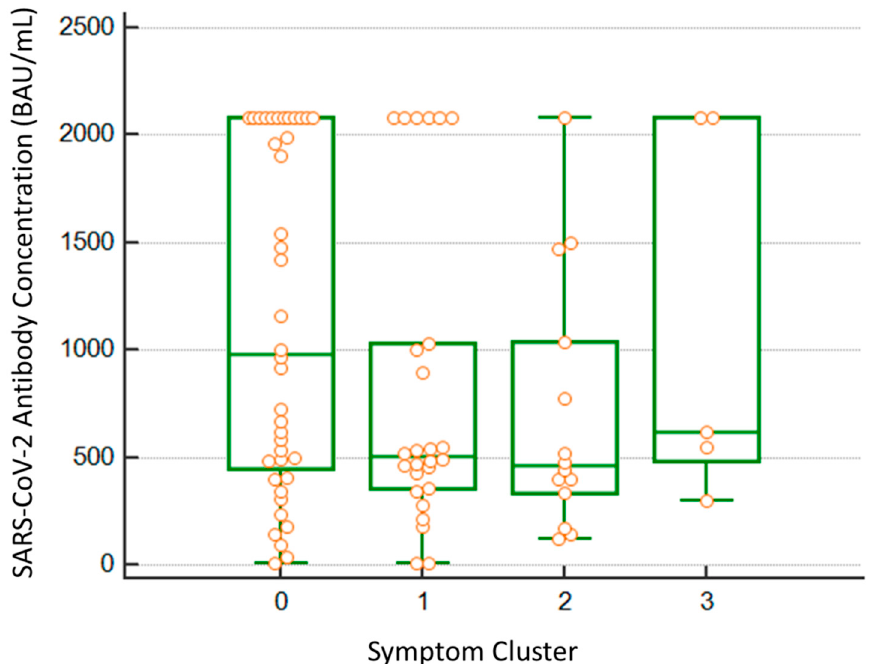
Figure 4. Differences in median BAU/mL SARS-CoV-2 previous antibody levels between four groups. 0: Non-symptomatic ( n = 40); 1: ‘Flu Like’ with fever ( n = 26); 2: ‘Flu-Like’ no fever ( n = 14); 3: Gastrointestinal symptoms ( n = 5). All single dots, including outliers, are overlaid on the box and whisker plot.